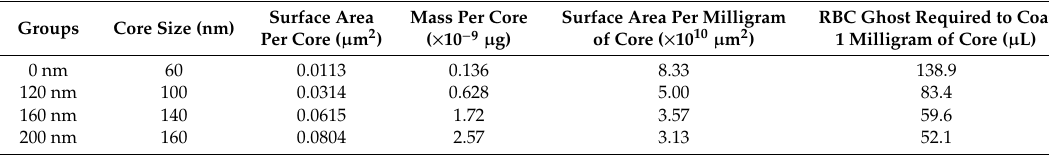
Table 1. Red blood cell (RBC) membranes required to fully coat di ff erently sized poly(lactic-co-glycolic acid) (PLGA)